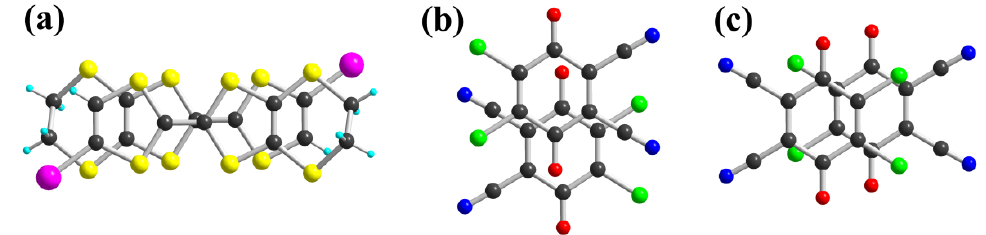
Figure 2. Overlap interactions ( a ): within ( 1 +· ) (DDQ − · ) running along